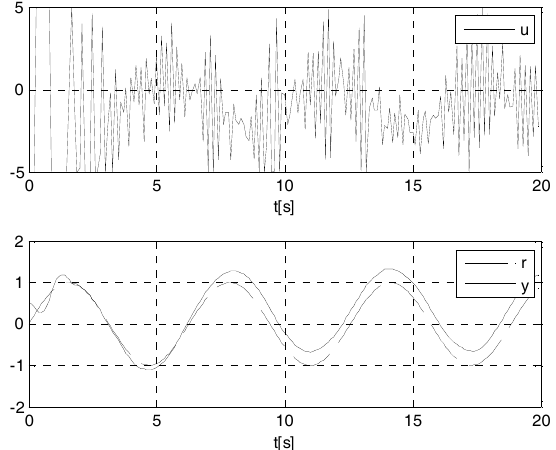
Figure A4. Time histories of u , r , and y with the MPC controller in the hypothesis of measurement noise on y .